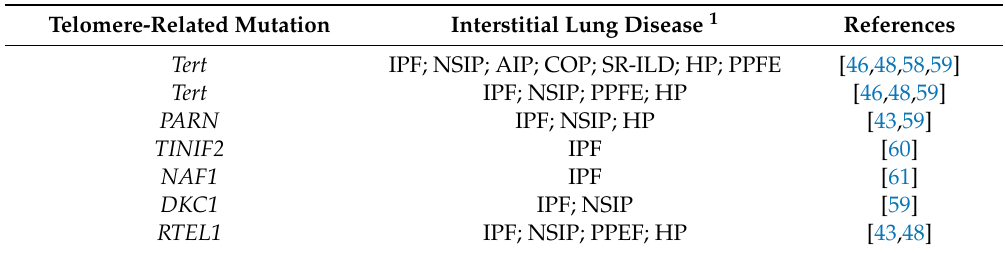
Table 1. Association between telomere-related mutation and interstitial lung disease. Telomere-Related Mutation Interstitial Lung Disease